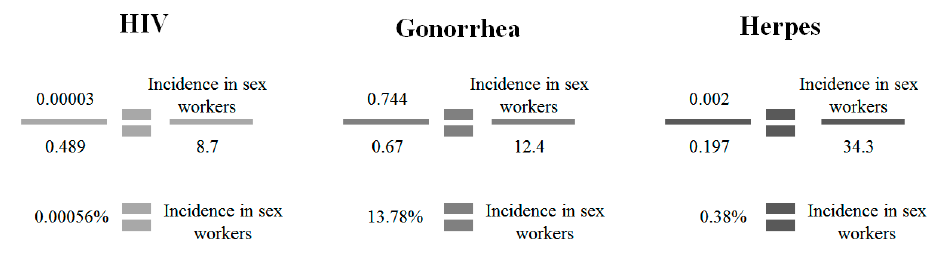
Figure A2. Prevalence of condomless sex after decriminalization.